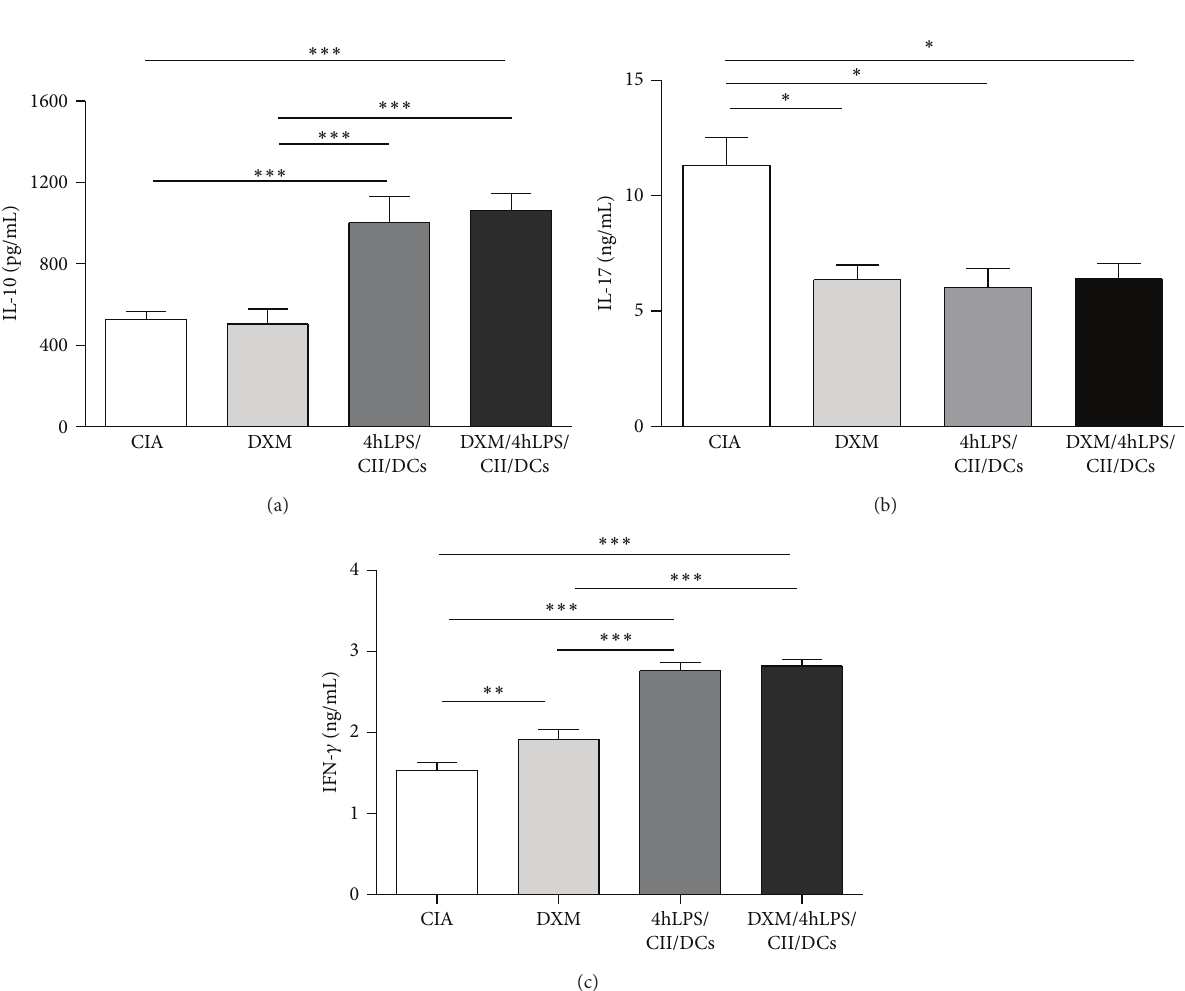
Figure 3: Cytokine production by CD4+ T cells from mice with active collagen-induced arthritis (CIA), treated with an inoculation of 4-hour lipopolysaccharide-(LPS-) stimulated dendritic cells (DCs) and dexamethasone (DXM) preconditioning. Mice received 2.0 mg/kg DXM from day 29 to day 34 after CIA induction (DXM group). Another group of mice were additionally injected at day 35 with 5 × 10 5 4-hour LPS-stimulated DCs loaded with type II collagen (CII) (DXM/4hLPS/CII/DCs group). The 4hLPS/CII/DCs group received 4-hour LPS-stimulated DCs loaded with CII, but without DXM preconditioning. The CIA control group corresponds to mice that did not receive any treatment. CD4+ T cells purified from mouse spleens at day 47 after CIA induction were stimulated with concanavalin A for 72 hours, and IL-10, IL-17, and IFN- 𝛾 levels in supernatants were quantified by ELISA. Bars represent the mean of three